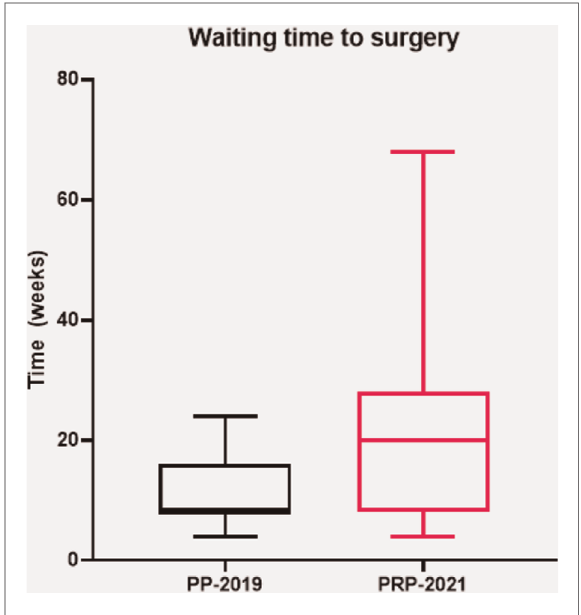
FIGURE 1 Waiting time to surgery between the two groups. PP-2019 - Pre- pandemic group; PRP-2021: Pandemic recovery phase